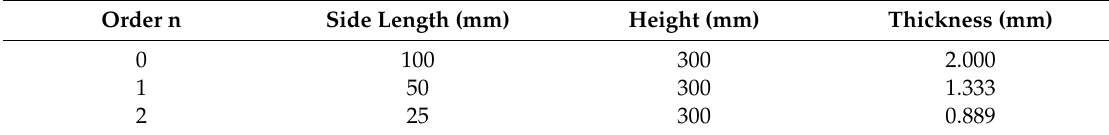
Table 4. Configuration details of FTTC series.